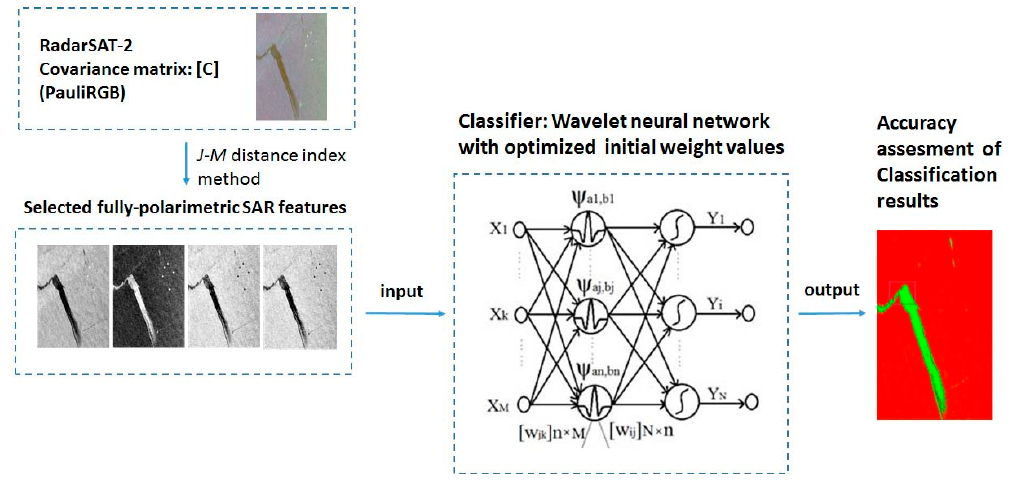
Figure 3. Frame chart of experimental process for ocean oil spill classification.